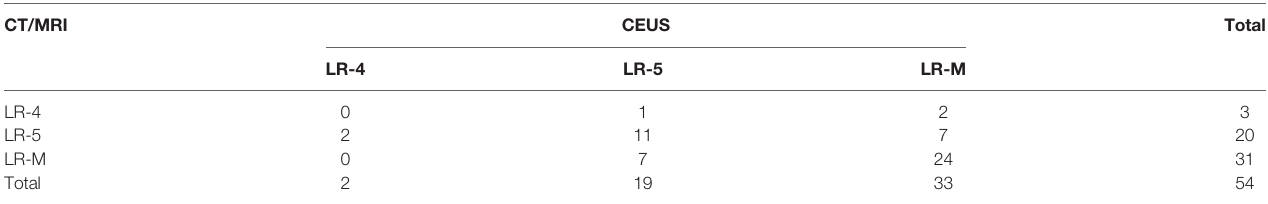
TABLE 4 | LI-RADS categorizations of cHCC-CCAs by CEUS and CT/MRI. CT/MRI